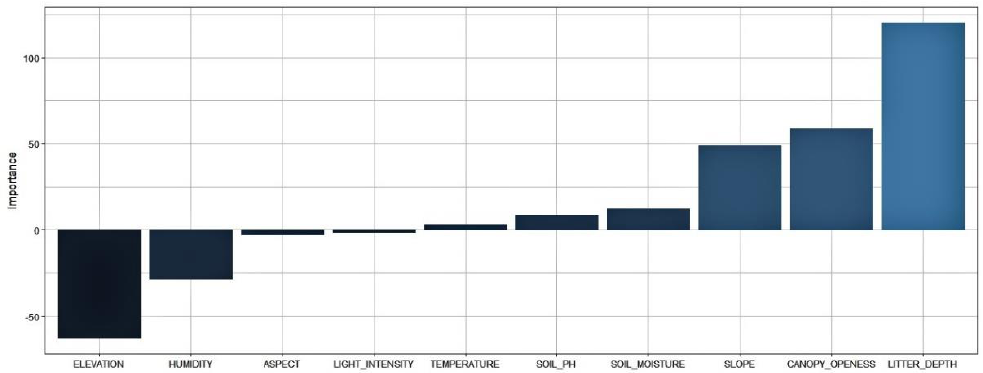
Figure 7. The importance of the ten explanatory variables for the response variable in determining species presence using ANN.